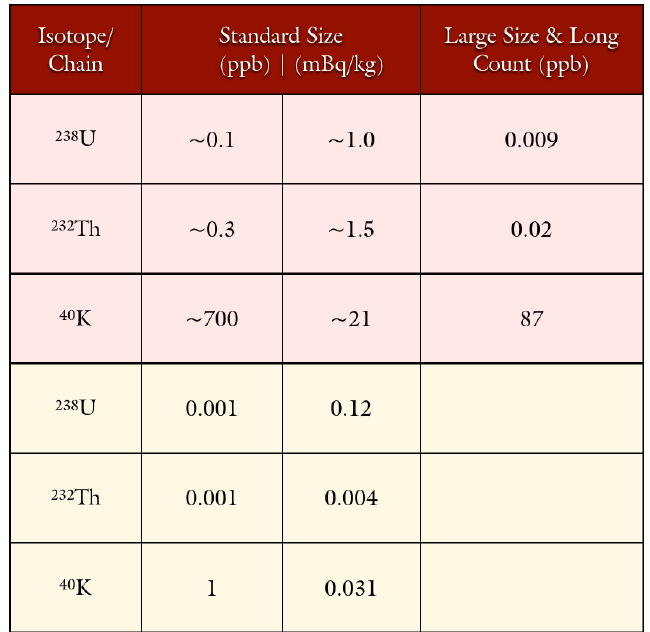
Figure 18: A comparison of material screening capabilities for various isotopes show- ing the difference between augmented commercial approaches (top three rows, light red) and custom approaches (bottom three rows, light yellow). Standard-sized sam- ples are compared between both approaches, while large-sized samples with long counting times to integrate radiation exposure to the instrumentation is shown only for an augmented commercial